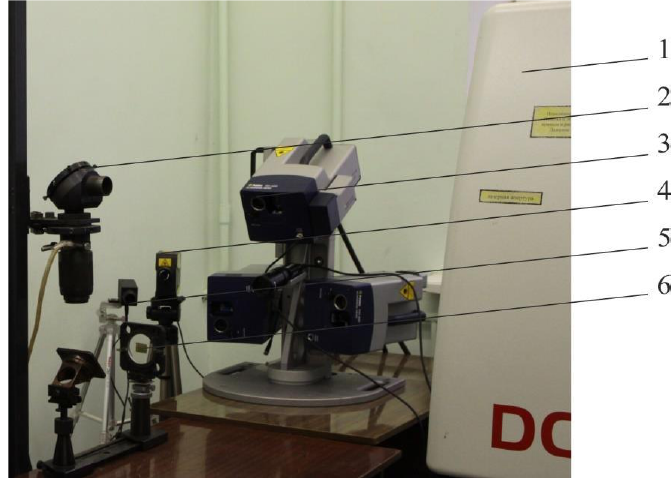
Figure 8. Photo of the setup used to study the vibration characteristics of the samples: 1—pulse- periodic laser; 2—three-coordinate scanning laser vibrometer; 3—mirror of optical system; 4—two- coordinate scanning laser vibrometer; 5—non-contact thermometer; 6—Cu-Zn alloy sample [152].